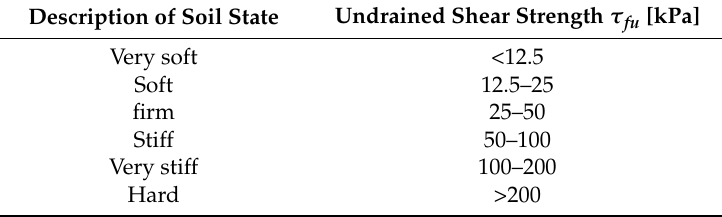
Figure 4. Chart for estimating mineral and organic soils [7]. Table 2. Soil states based on undrained shear strength [25].